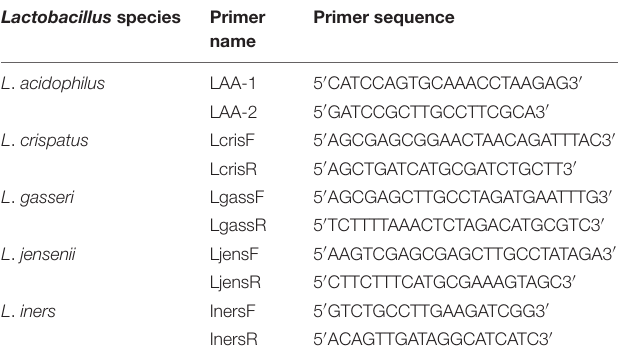
TABLE 2 | 16S rRNA Lactobacillus species-specific primers (Pelzer et al., 2018a). Lactobacillus species